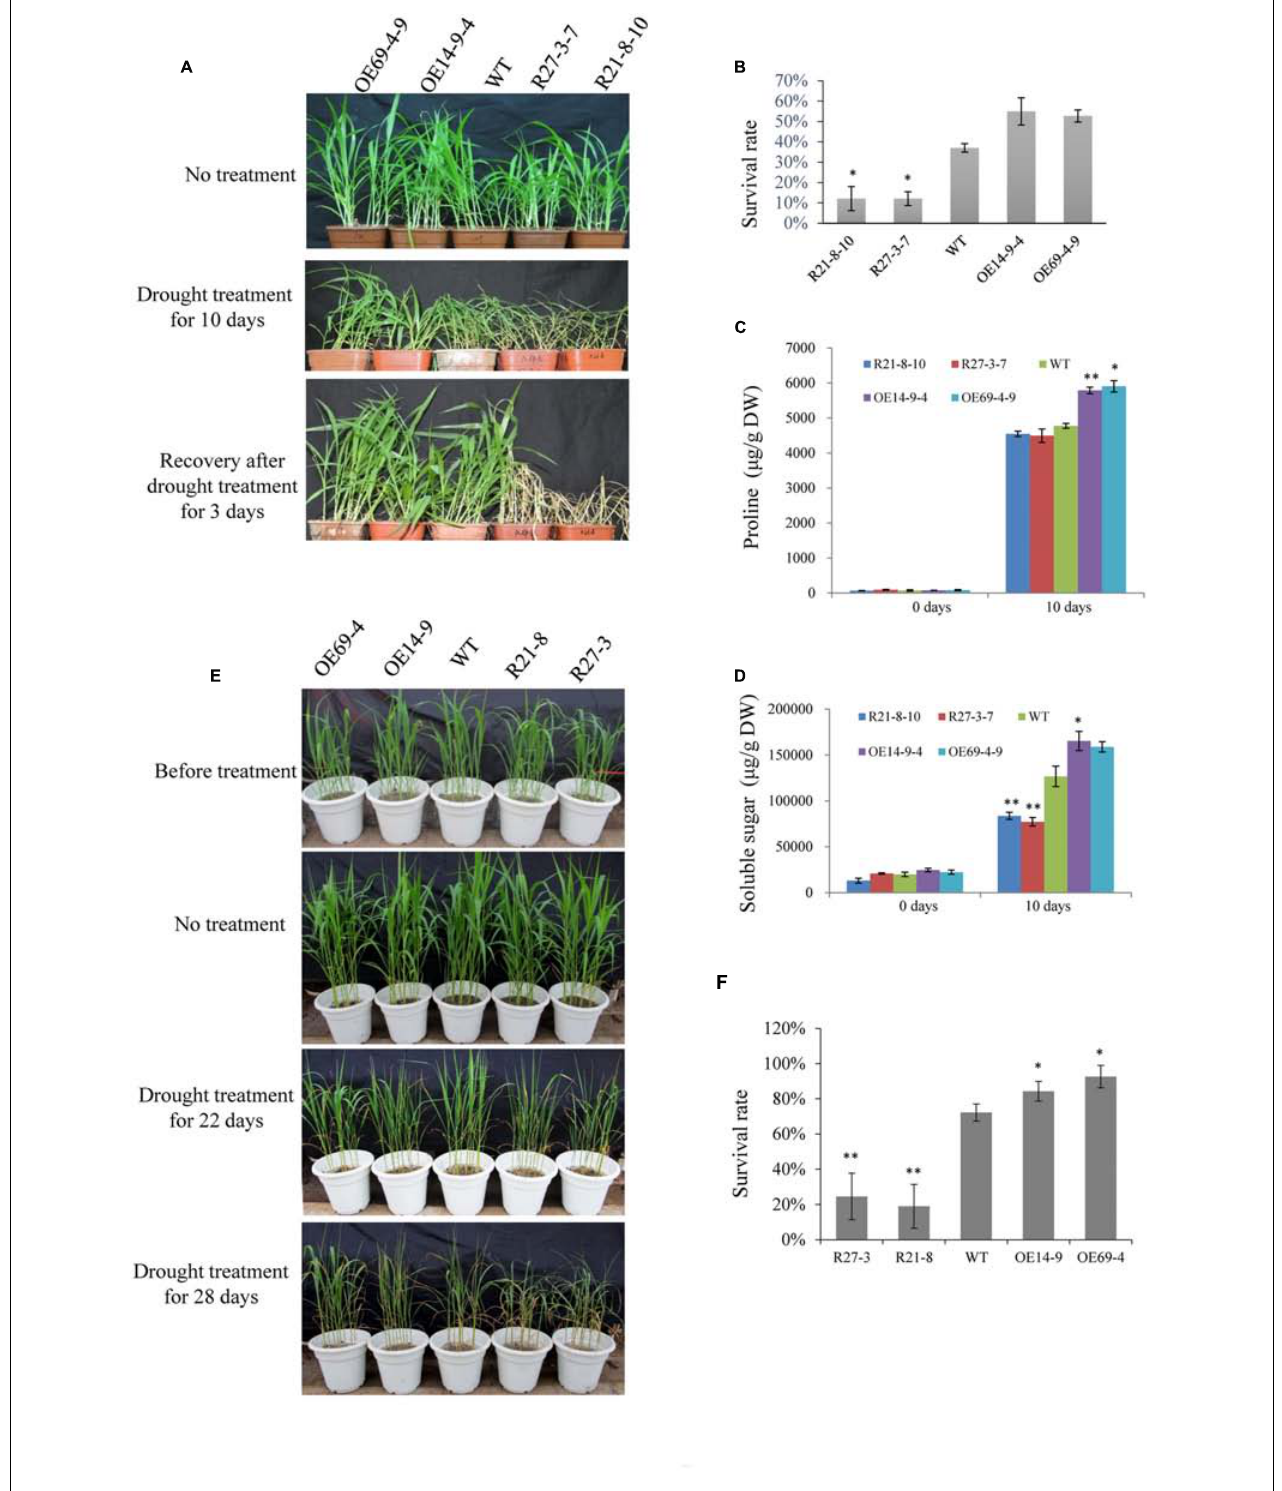
FIGURE 8 | Drought tolerance of SiLTP-OE and RNAi foxtail millet. The phenotype of the 2-week-old transgenic foxtail millet seedlings under drought treatment (A) . The survival rates of transgenic foxtail millet and WT plants (B) . Proline contents (C) and soluble sugar contents (D) in WT and transgenic plants after drought stress. The drought tolerance phenotypes of SiLTP-OE and RNAi foxtail millet at the reproductive stage (E) and the survival rates of transgenic foxtail millet (F) . ∗ and ∗∗ indicate statistically significant differences at P < 0.05 and P < 0.01 (Student’s t -test), respectively.